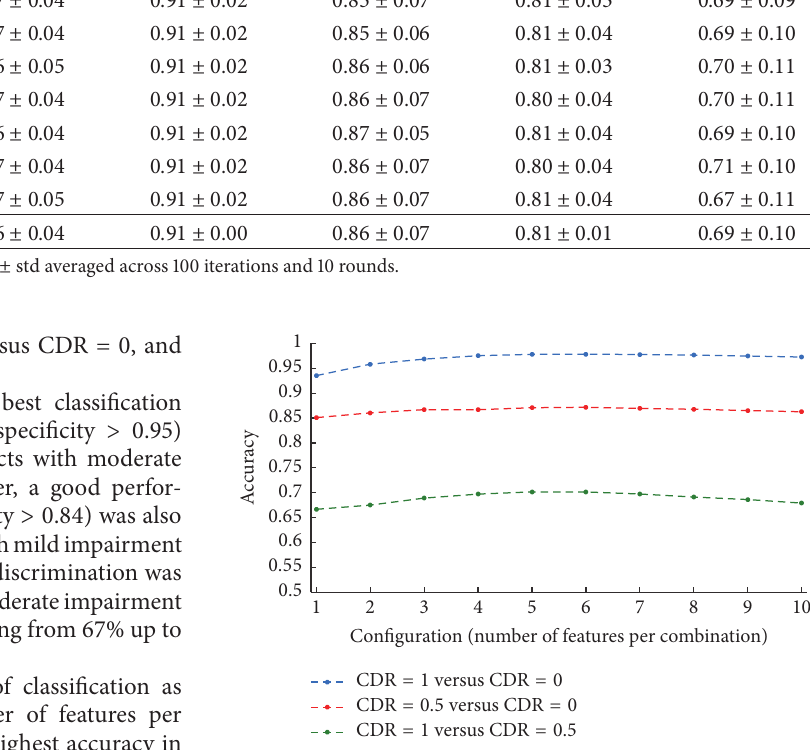
Figure 3: Highest accuracy of classification as a function of the configuration (combination of input features) in the inner loop of the nested CV. Performances are reported for CDR = 1 versus CDR =0(blue),CDR=0.5versusCDR=0(red),andCDR=1versusCDR = 0.5 (green), using the features chosen by the neuropsychologists. Results were obtained as average across all rounds (10) and iterations